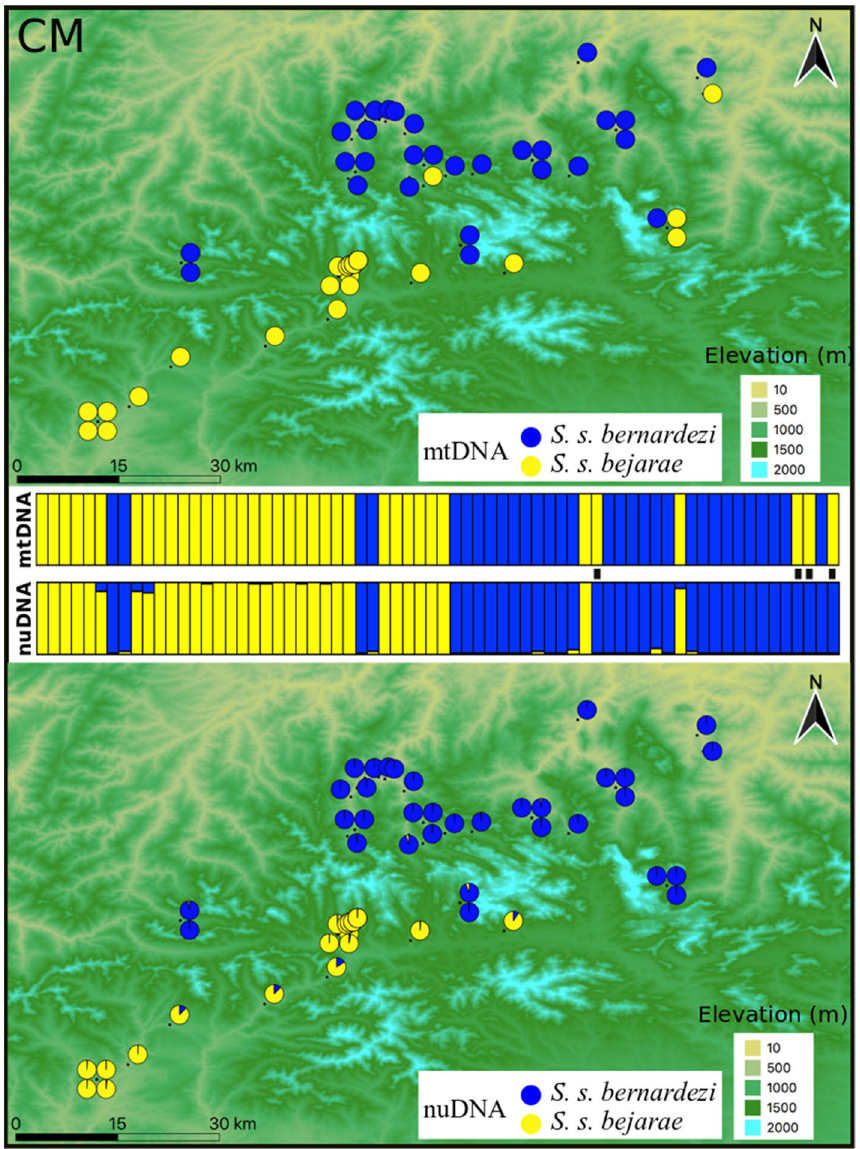
Figure 3. Genetic structure of S. salamandra across the Cantabrian Mountains (CM) as inferred by both mitochondrial (upper panel; two main lineages separating S. s. bernardezi and S. s. bejarae ) and nuclear DNA (lower panel; STRU CTU RE K = 2). Samples in the barplots are arranged from west to east. Genetic assignment to S. s. bernardezi or S. s. bejarae is colour-coded in blue and yellow, respectively. Black bars between structure plots indicate individuals with mitonuclear discordance (6%). The figure was created with QGIS software (version 3.2; https:// qgis. org/ en/